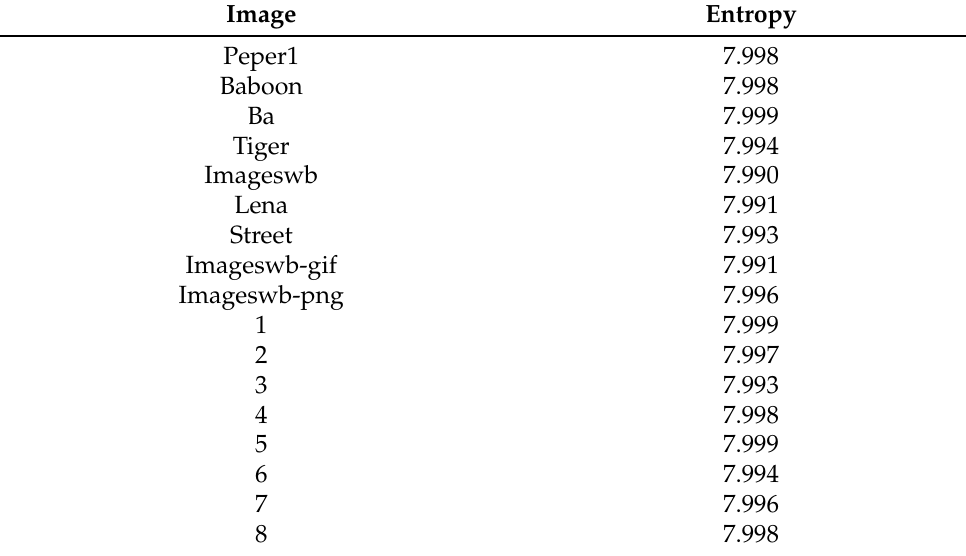
Table 1. The entropy values of the cipher